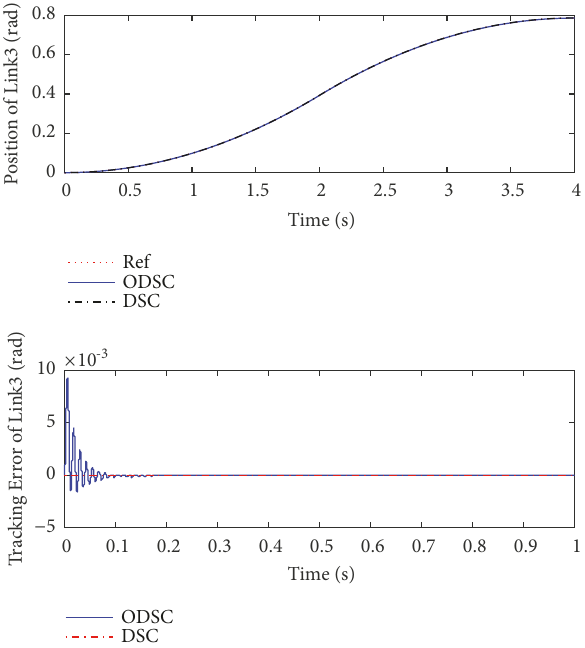
Figure 5: The position and tracking error of